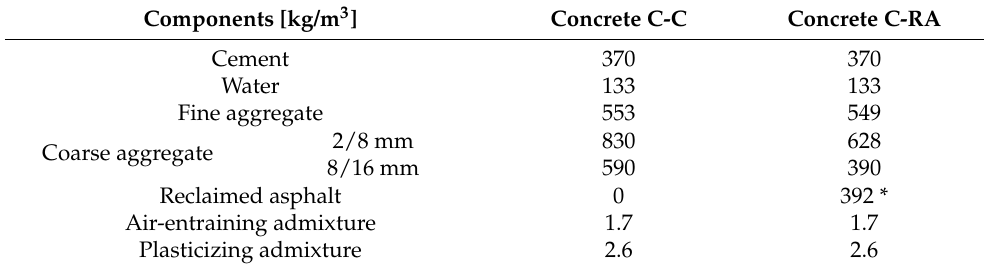
Table 6. Mixture